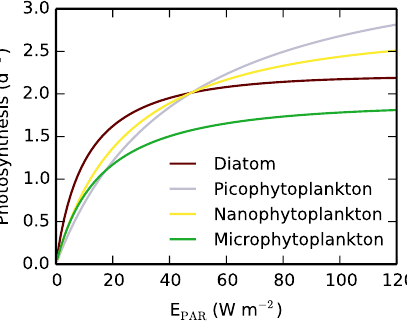
Figure 13. Phytoplankton growth over PAR for the four phyto- plankton